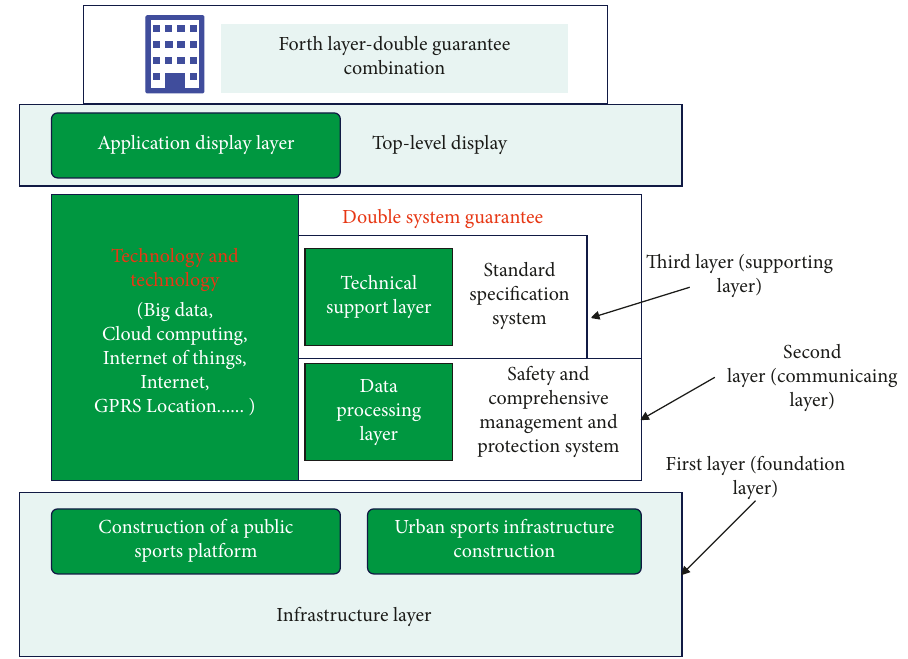
Figure 9: Development framework of “smart